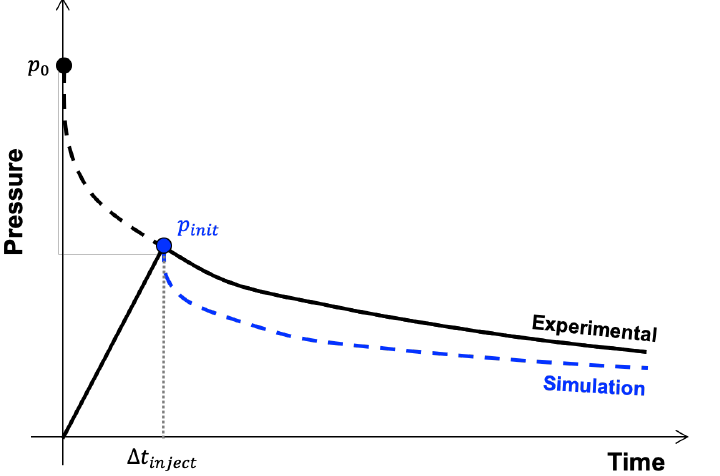
Figure 8. Visualization of the difference between first pressure points in simulated curve ( p init ) and experimental curve ( p 0 ), and the resulting effect that simulated pressure decrease curves are necessarily lower than experimental ones. The value p 0 is equivalent to the pressure associated with all the gas injected in the UC if no dissolution happened, and cannot be directly measured. The value p init is chosen as the first pressure measurement after injection, that does not coincide with p 0 due to the finite injection rate. An infinite injection rate would lead to ∆ t inject = 0 and allow one to measure p 0